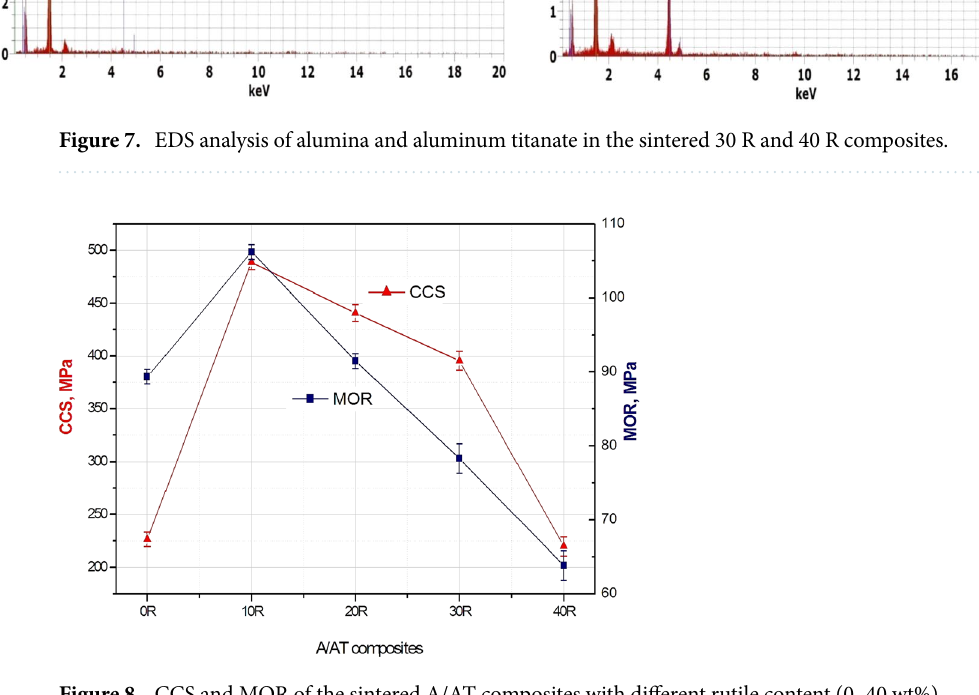
Figure 8. CCS and MOR of the sintered A/AT composites with different rutile content (0–40